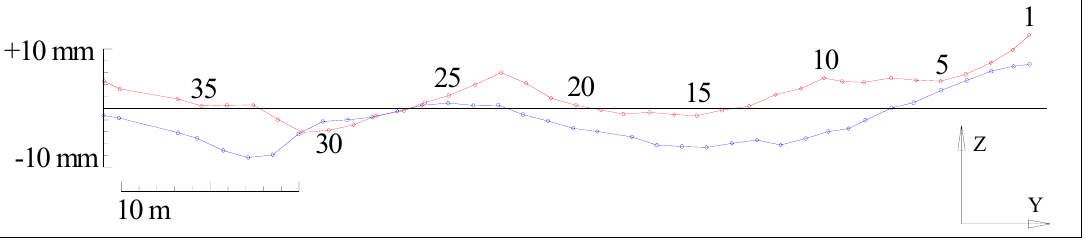
Figure 5. Graphical representation of deviations in vertical sense (red—left rail, blue—right